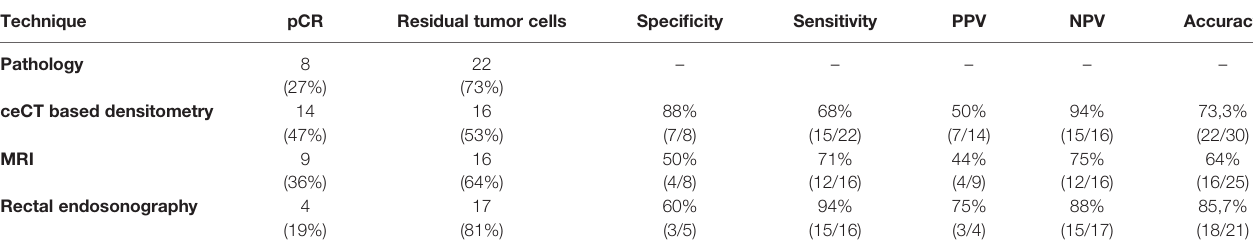
TABLE 1 | Comparison between different imaging techniques.